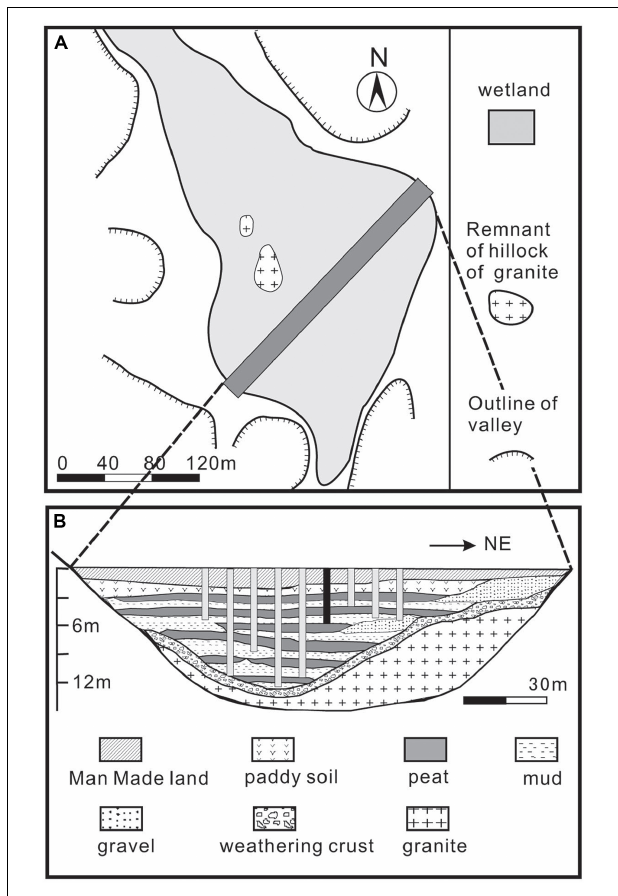
FIGURE 4 | Distribution (A) and cross section (B) of Dahu swamp (redrawn after Zhou et al., 2004; Zheng et al., 2008).